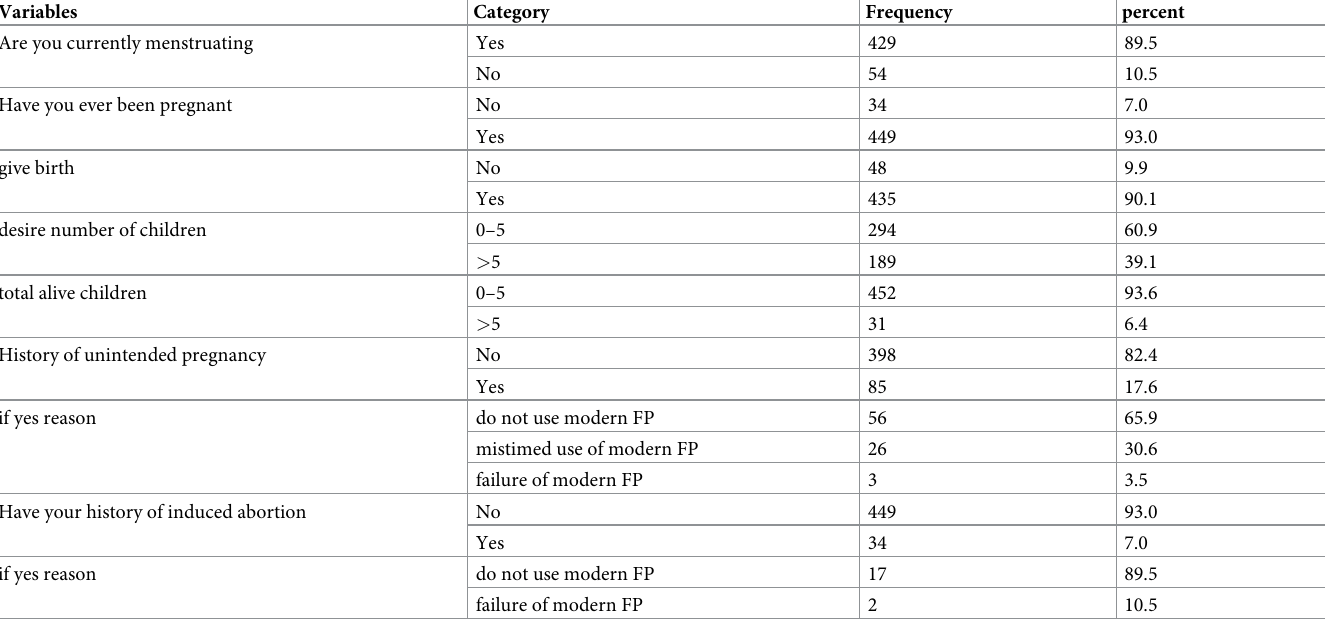
Table 6. Reproductive-related factors characteristics of reproductive age group women in South Gondar, Ethiopia, 2017 (n = 483).